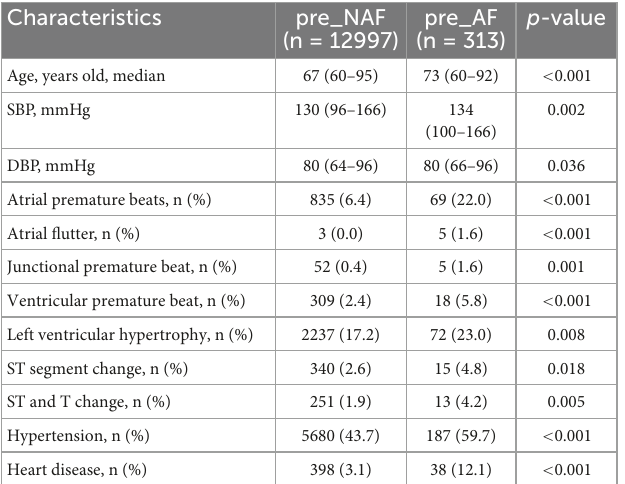
TABLE 5 Baseline characteristics of 12997 negative samples and 313 positive samples with p-values less than 0.05 under the Chi-square test and Mann-Whitney U test.